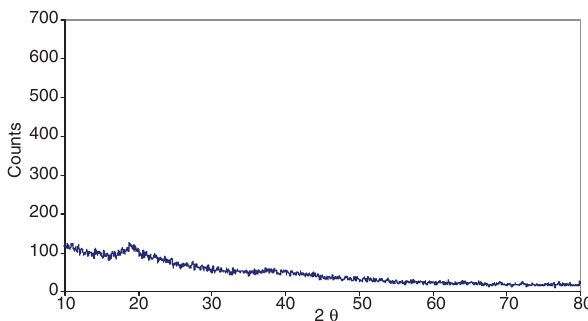
Figure 2 X-ray diffraction of silver-polyvinyl alcohol